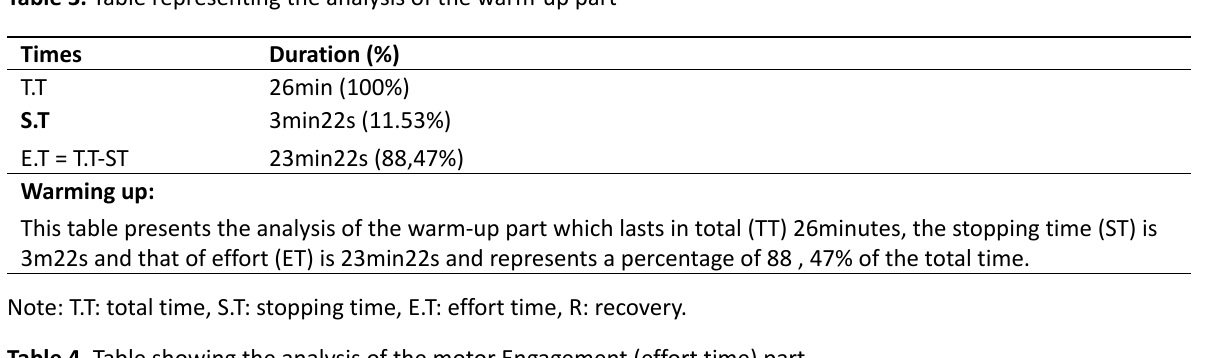
Table 4. Table showing the analysis of the motor Engagement (effort time) part. Times Duration